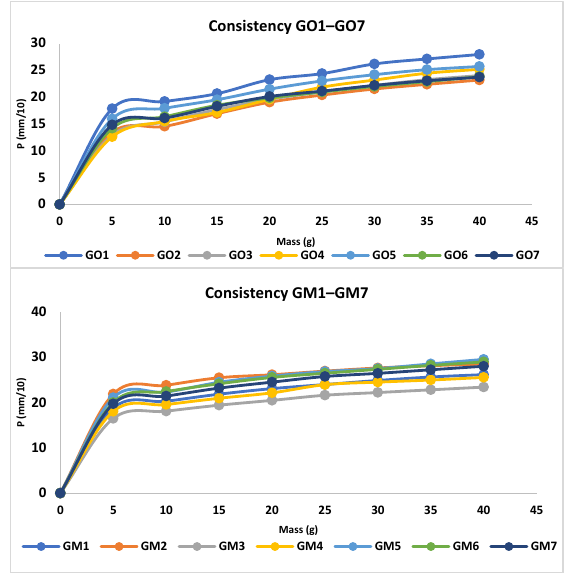
Figure 4. Consistency profiles for MIC and blank gels.